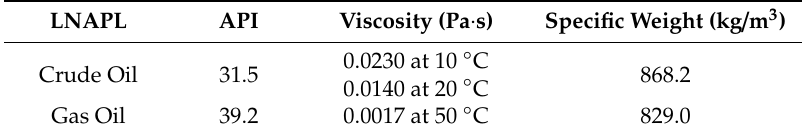
Table 1. Physical properties of LNAPLs.